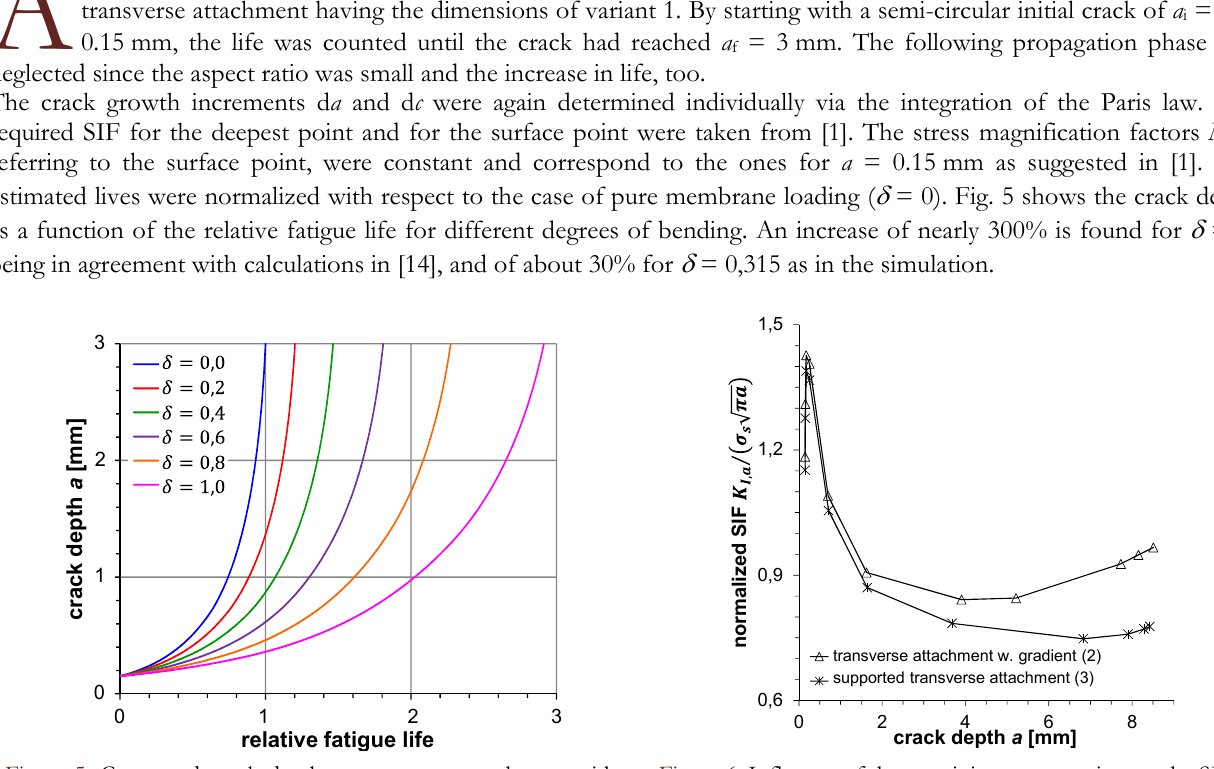
Figure 5: Computed crack depth at transverse attachment with different degrees of bending  vs. relative fatigue life.